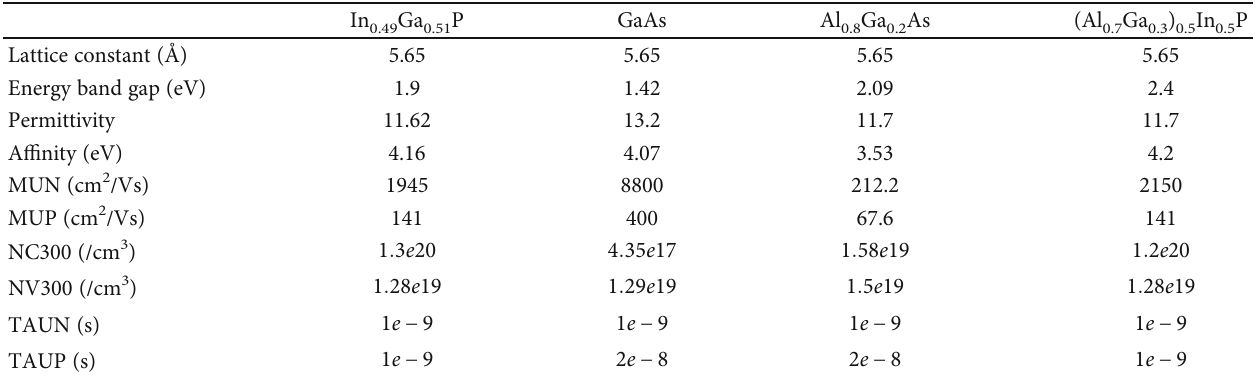
Table 2: Main required parameters of the optimum selected materials used for designing the InGaP/GaAs DJ solar cell [33 – 35].